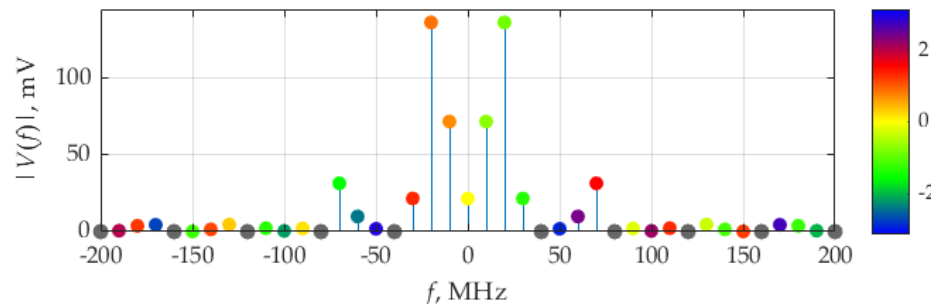
Figure 16. The voltage spectrum for the case of transmission line and pulse train current.